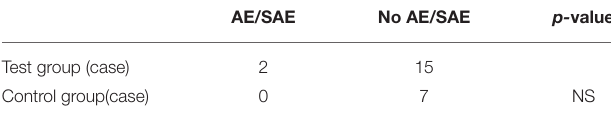
TABLE 3a | Safety: symptomatic adverse effect comparison.